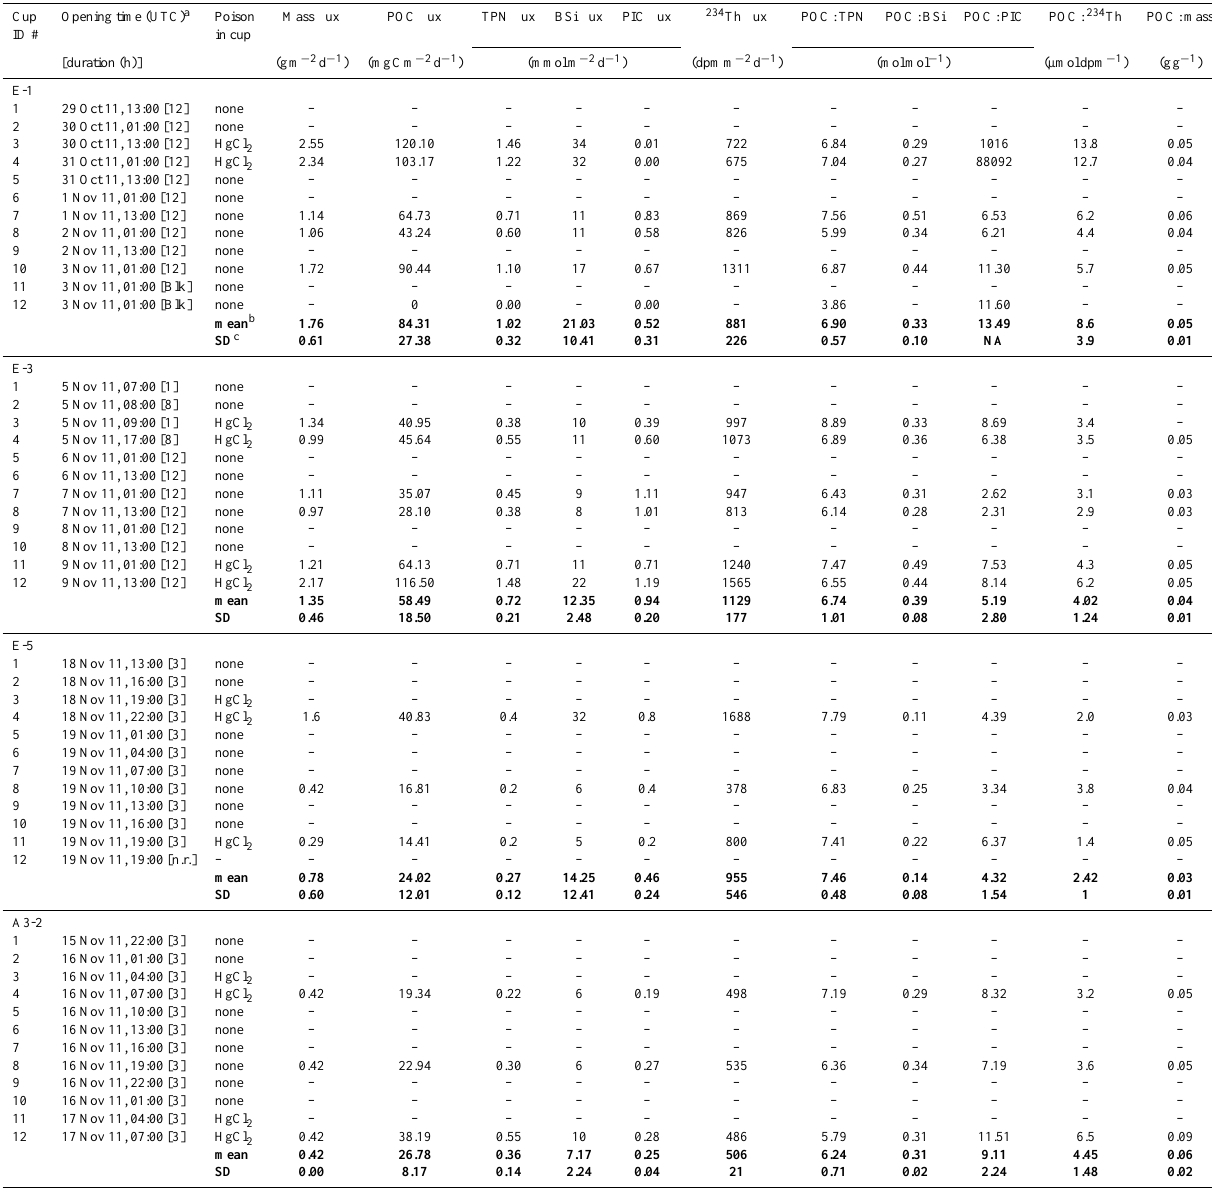
Table 4. Particle fluxes at 210m depth from free-drifting deployments of the 12-cup-carousel cylindrical PPS3/3 trap. The trap collection area was 0.125m 2 . Particles were washed through a 350µm Nitex screen to remove zooplankton and were collected on a 1mm silver filter. Mean values and their standard deviations are indicated in